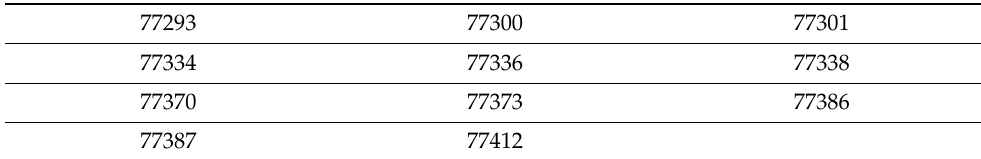
Table A1. Selected Common Procedure Terminology codes used in technical billing for selected cancer diagnoses in the Fee-For-Service